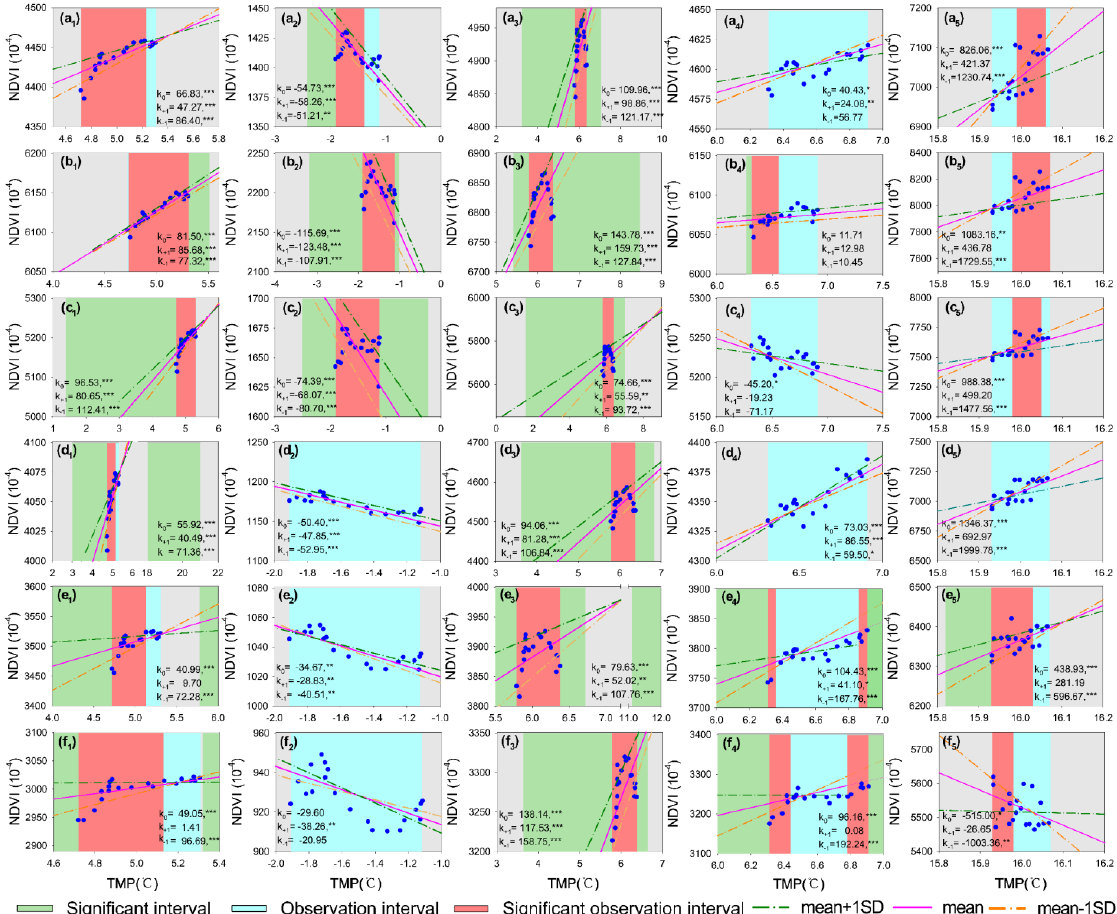
Figure 2. The regulating effect of precipitation on the relationship between temperature and NDVI. Mean and mean ± 1SD denote the regression equations established by temperature and NDVI when the precipitation was set as the mean and mean ± 1SD, respectively, and the corresponding simple slopes are k 0 and k ±1 . Significant intervals indicate the temperatures at which the precipitation presented a significant moderating effect, according to the J – N analysis range. The observation interval represents the actual observation interval of temperature. A significant observation interval indicates the actual temperature range for which the precipitation presented a significant regulation effect. Note: a – f refer to Mean, P 100 , P 75 , P 50 , P 25 , and P 5, respectively; 1 – 5 refer to SW, T +* – P +* , T +* – P – , T +* – P + , and NSC, respectively.